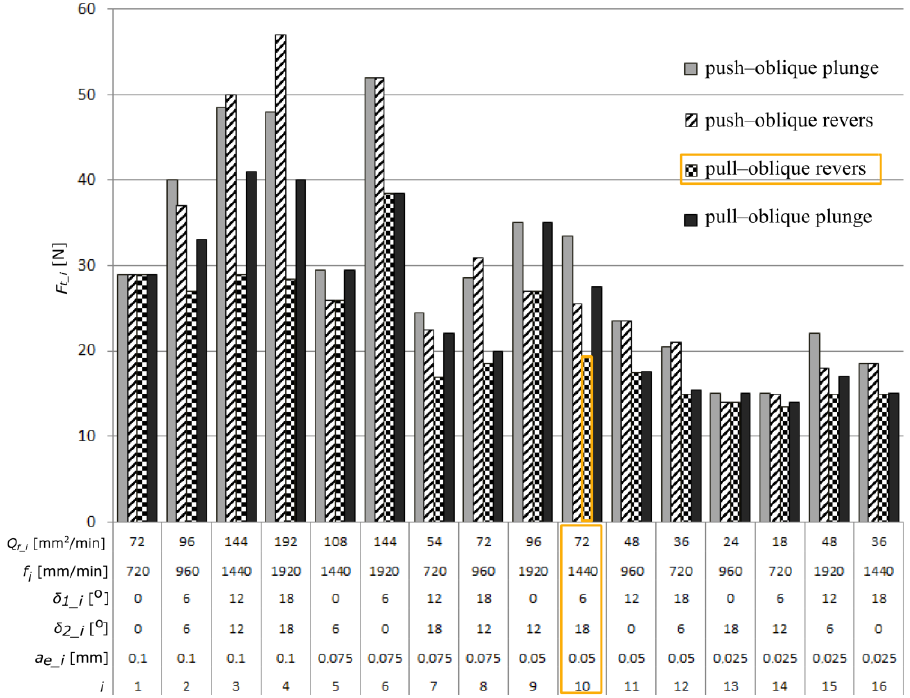
Figure 11. The average values of the tangential component of the total cutting force F t , calculated in the analyzed machining cases.